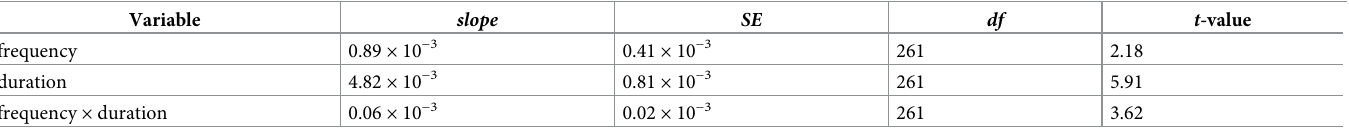
Table 2. Summary of the LMER model fitted to the rating difference for 25 conditions in switchable participants ( n = 11). Variable slope SE df t -value frequency duration frequency ×